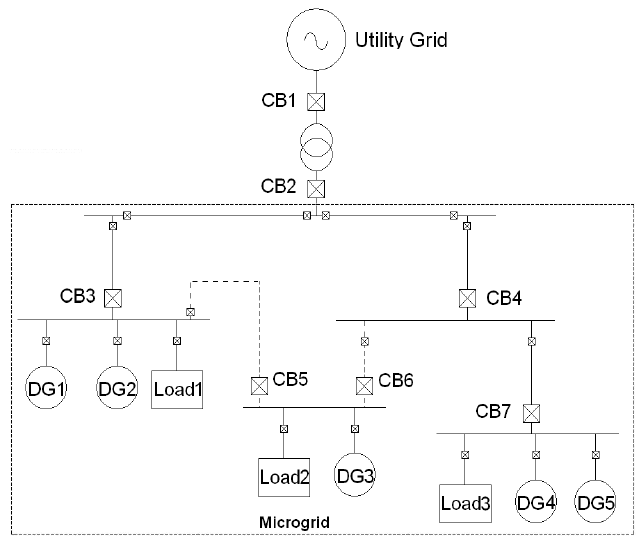
Figure 2. A sample Figure 2. A sample microgrid.